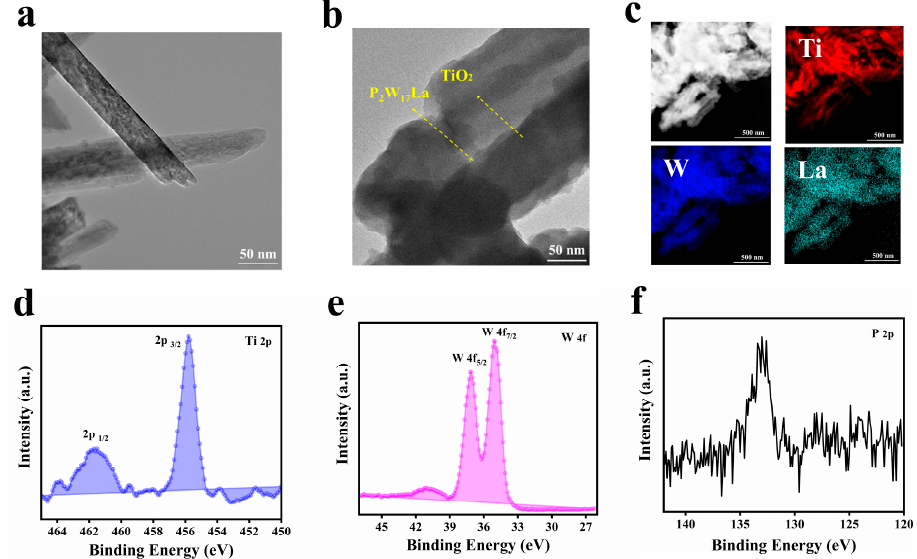
Figure 3. TEM images of ( a ) TiO 2 NW and ( b ) NW–P 2 W 17 La. ( c ) EDS elemental mapping patterns of Ti, W, and La in the NW–P 2 W 17 La films. ( d – f ) Ti, W, and P XPS spectra of the NW–P 2 W 17 La composite film.